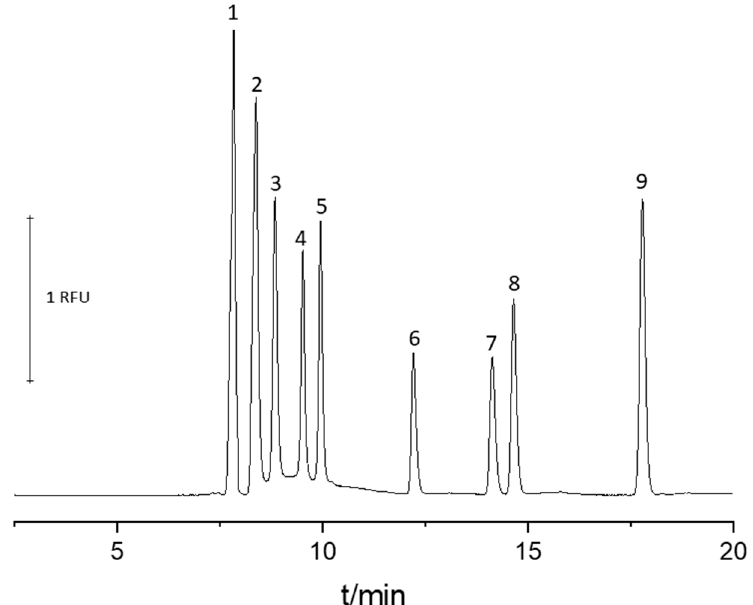
Figure 2. Representative electropherogram obtained from the separation of nine pterins standards under optimized conditions with LED-induced fluorescence detection. Separation was carried out in a fused-silica capillary (35 cm effective length, 56 cm total length, 50 µ m internal diameter). The BGE was 100 mM sodium tetraborate, 100 mM TRIS, and 2 mM EDTA sodium salt at pH 9.6. Sample injection was at 50 mbar for 6 s. The analytes concentration was 12 µ M. The separation voltage was − 17.5 kV. Detection was at λ exc/ λ em = 365/450 nm. Peak identification: 6,7-dimethylpterin (1), 7-biopterin (2), 6-hydroxymethylpterin (3), neopterin (4), pterin (5), lumazin (6), isoxantoptein (7), xantopterin (8), 7-hydroxylumazin